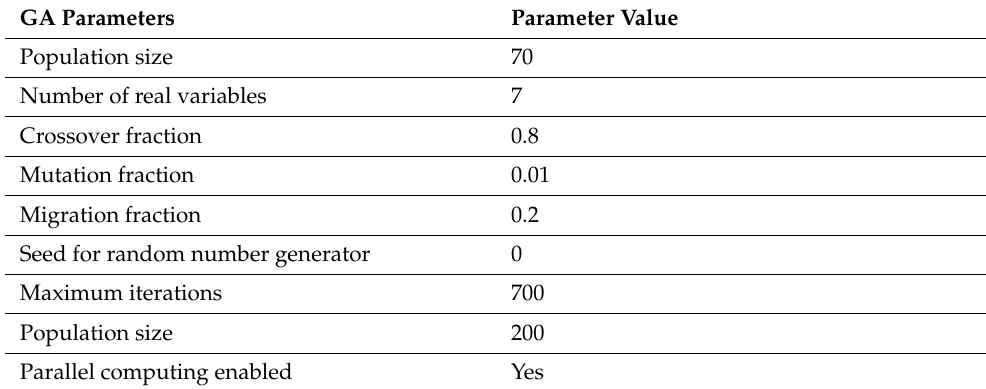
Table 4. Parameters used in the genetic